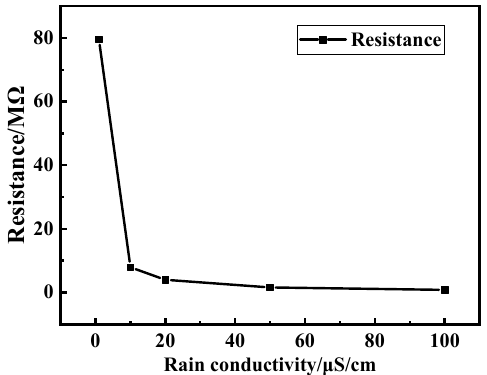
Figure 12. The relationship between ESDD and rain conductivity for sample B.